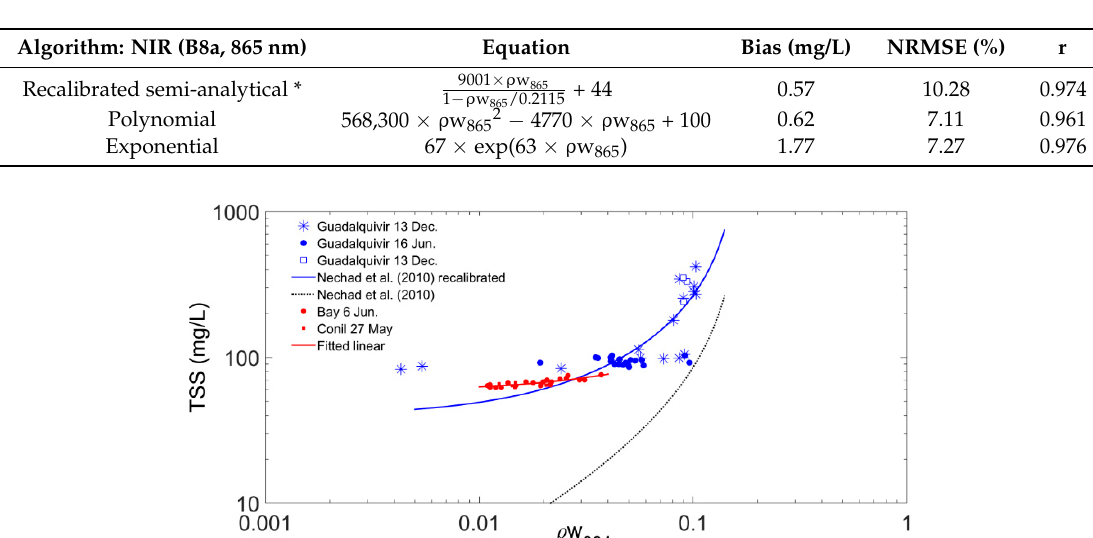
Table 3. Algorithms tested for Total Suspended Solids (TSS) estimation in the Guadalquivir estuary based on the water reflectance ( ρ w) of the near-infrared (NIR) band (B8a, 865 nm). The Pearson correlation coefficient (r, p < 0.001), bias (mg/L), and Normalized Relative Root Mean Square Error (NRMSE, %) are indicated with the final equation for each one. The * corresponds to the Nechad et al. (2009) model [29].